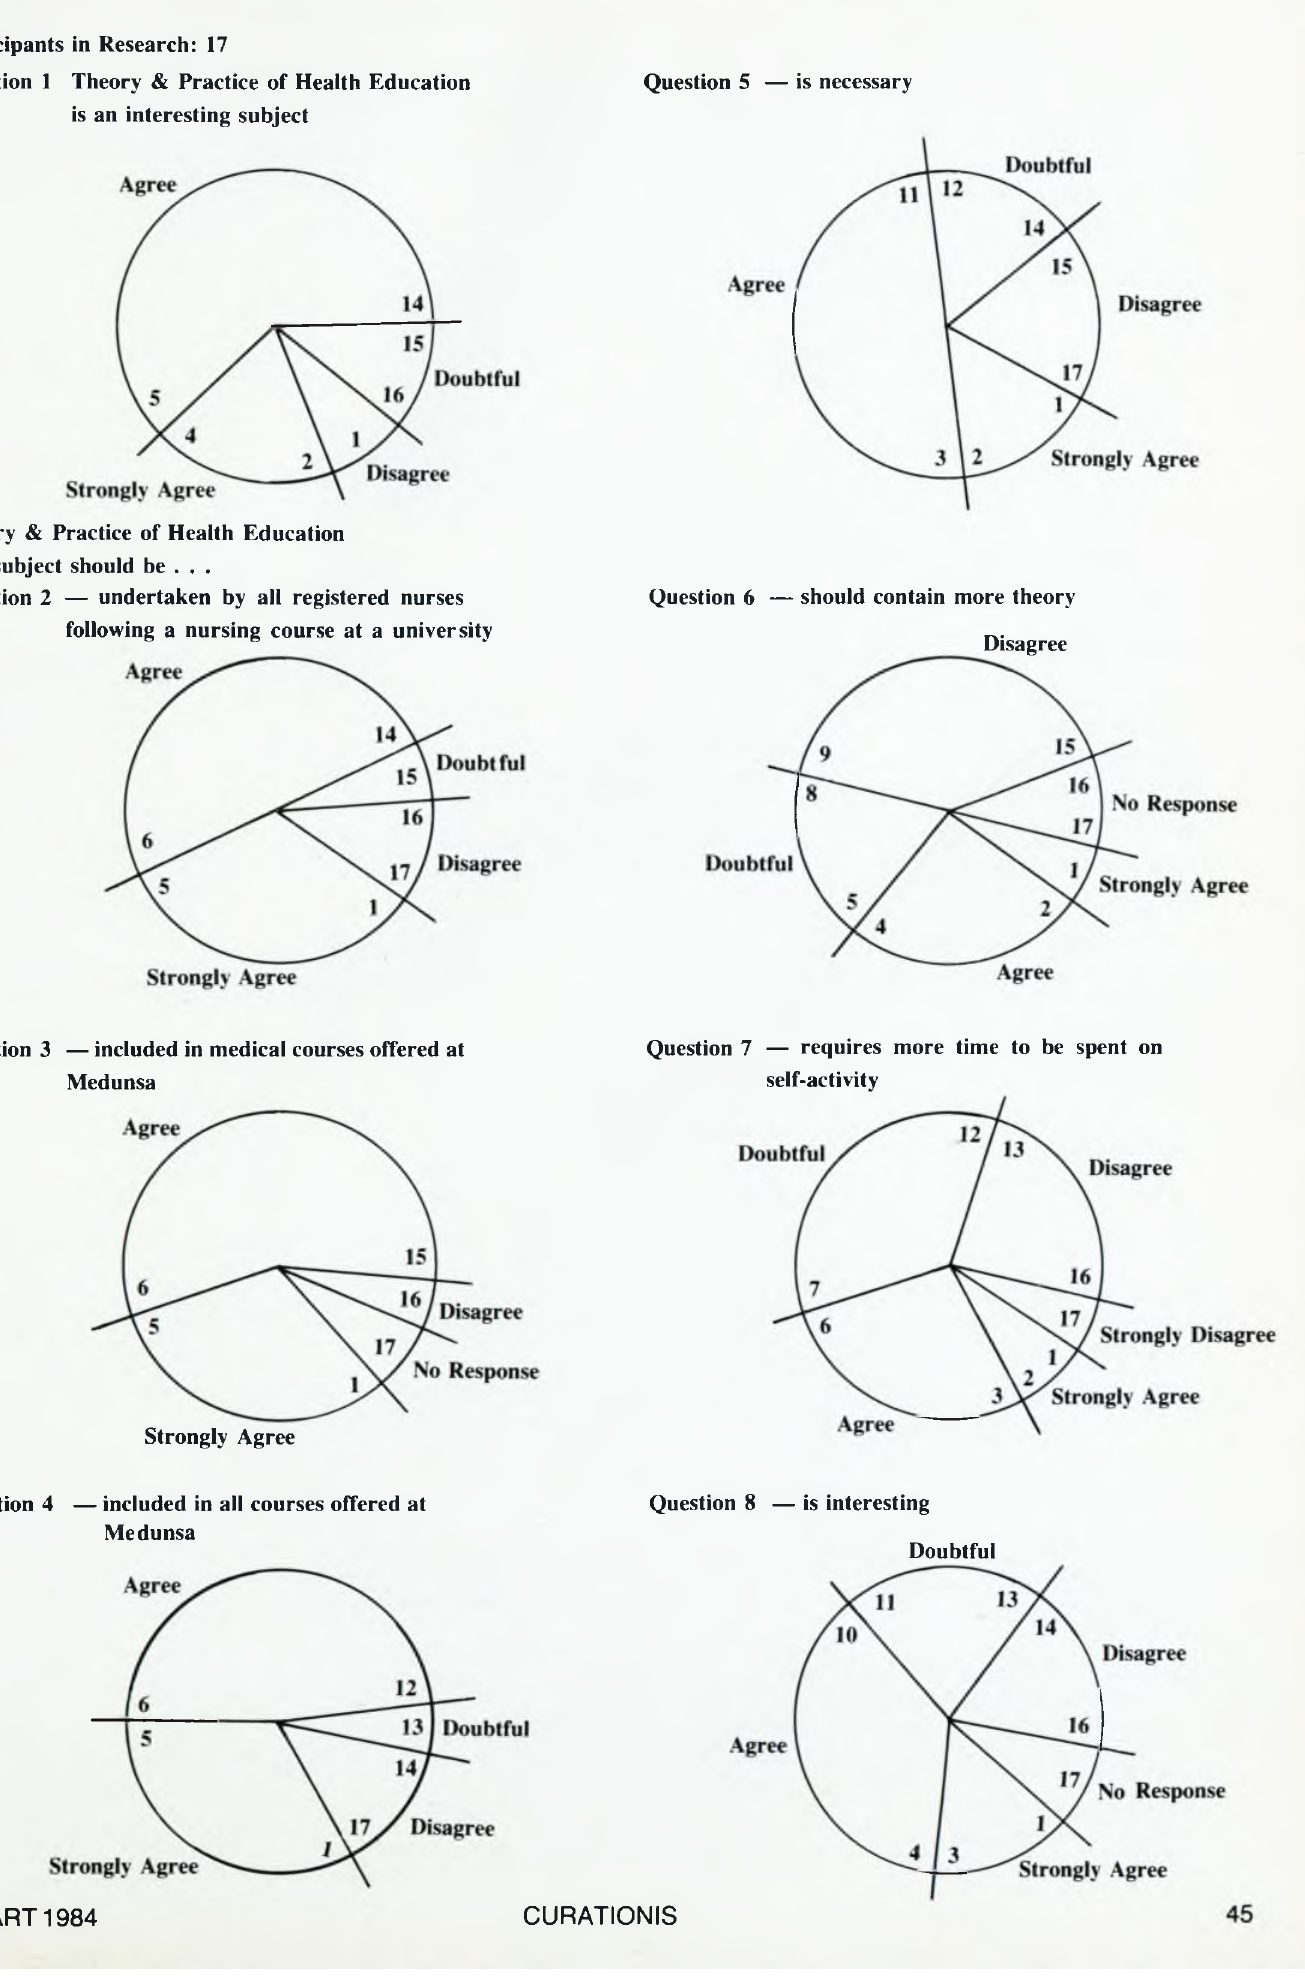
Table I: Analysis of responses to a questionnaire on the Subject Theory and Practice of Health